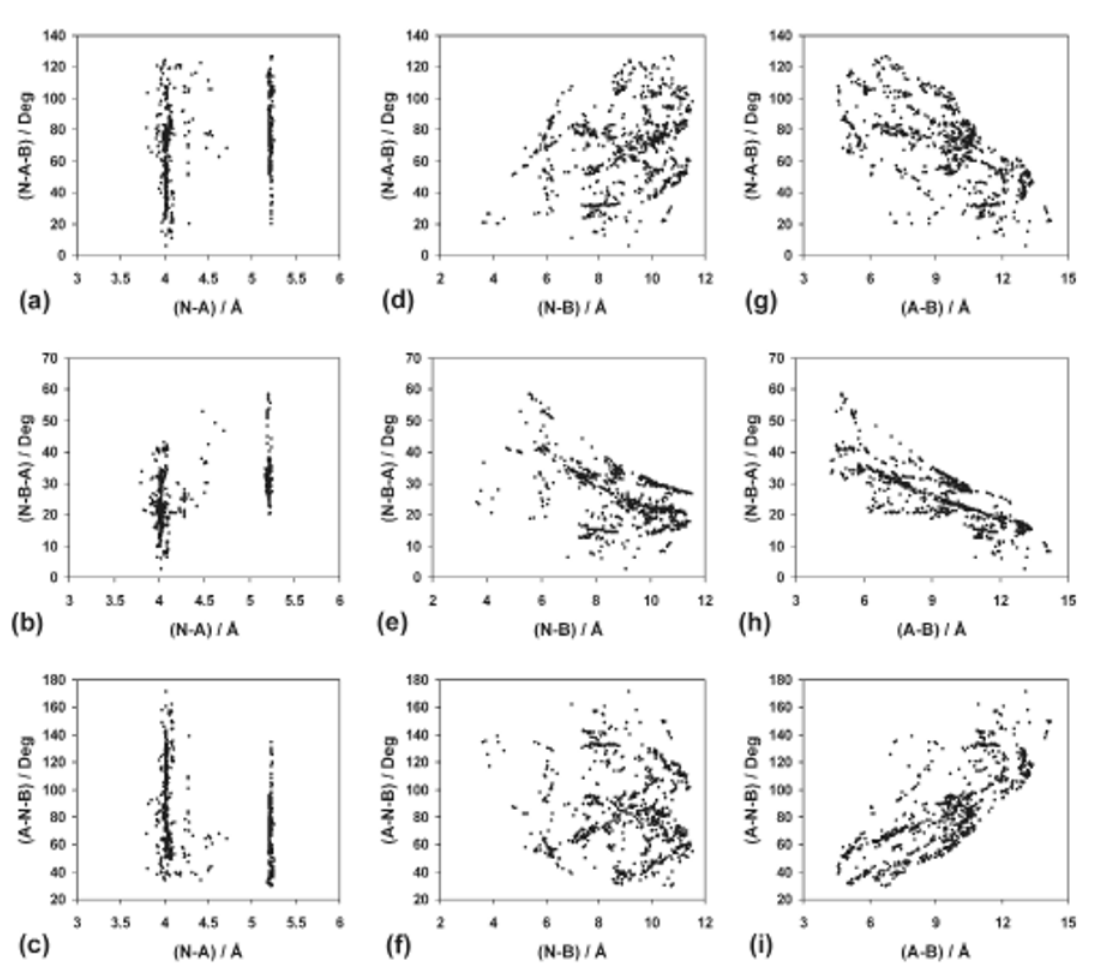
Figure 2. Nine different types of distance-angle maps, regarding the first subgroup of pharmacophore elements, for the S[1] stereoisomer: ( a ) the ( N-A ) – ( N-A-B ), ( b ) the ( N-A ) – ( N-B-A ), ( c ) the ( N-A ) – ( A-N-B ), ( d ) the ( N-B ) – ( N-A-B ), ( e ) the ( N-B ) – ( N-B-A ), ( f ) the ( N-B ) – ( A-N-B ), ( g ) the ( A-B ) – ( N-A-B ), ( h ) the ( A-B ) – ( N-B-A ) and ( i ) the ( A-B ) – ( A-N-B )